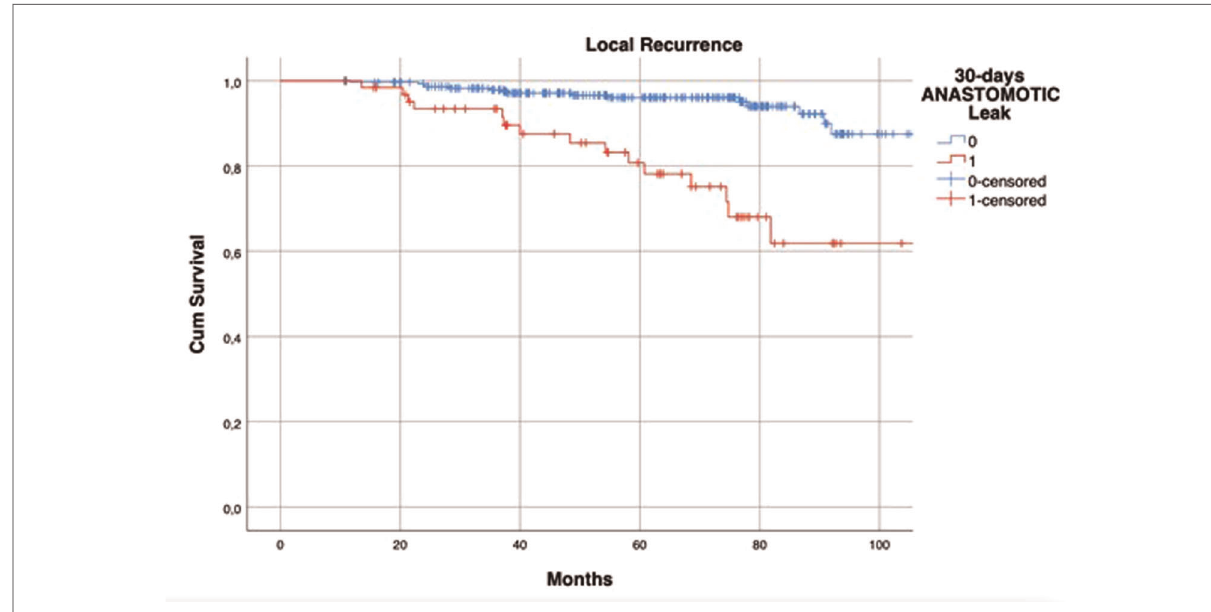
FIGURE 2 Kaplan – Meier curves of disease-free survival, according to the occurrence of postoperative anastomotic leakage. p =0.04 (log rank